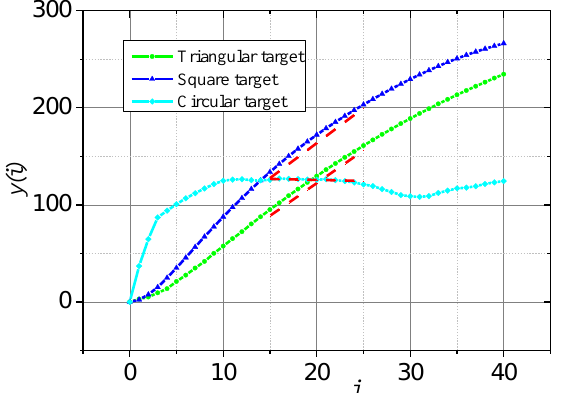
Figure 4. Relation curve between y ( i ) and i for di ff erent targets.